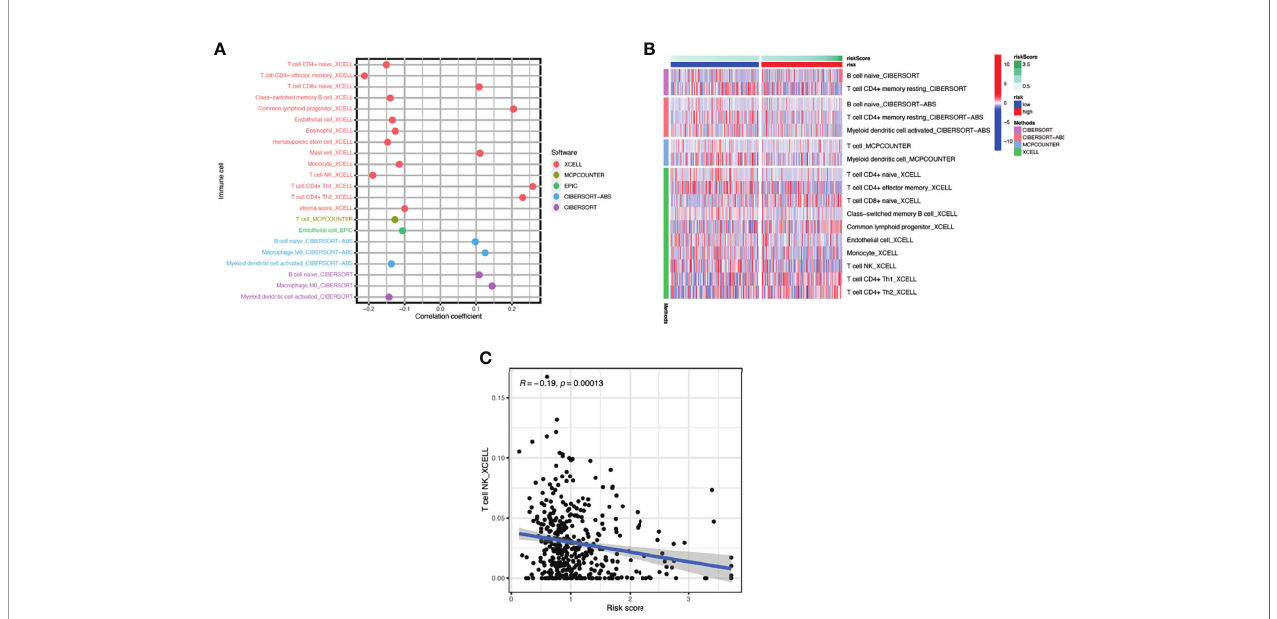
FIGURE 7 | The interaction of risk score and immune-related in fi ltration cells. (A) Correlation of immune cells in fi ltration and risk scores using fi ve different methods. (B) Differential in fi ltration of immune cells between high- and low-risk-score patients. (C) Correlation between risk scores and NKT cells in fi